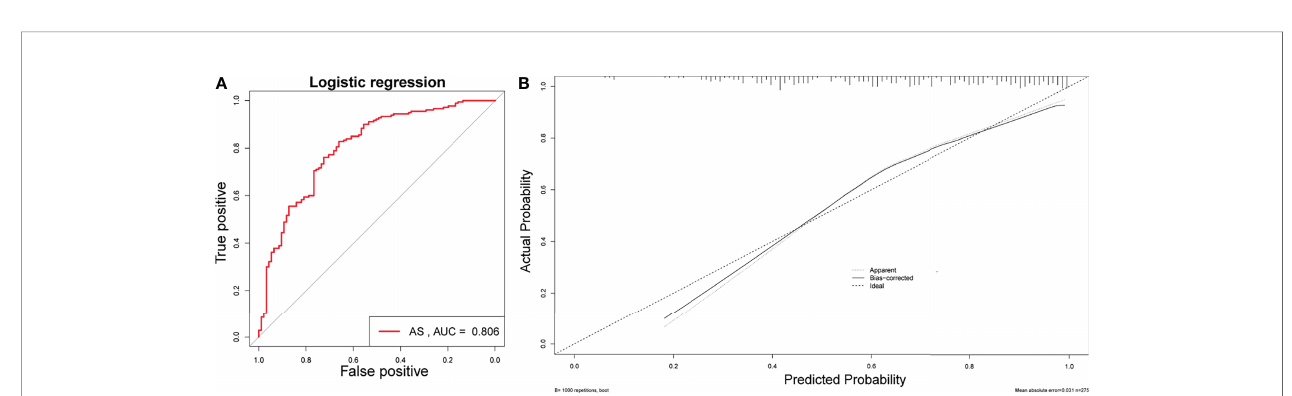
FIGURE 2 | Validation of the nomogram. (A) AUC of the nomogram based on the 5 characteristics. (B) Calibration curves for predicting AS probability.